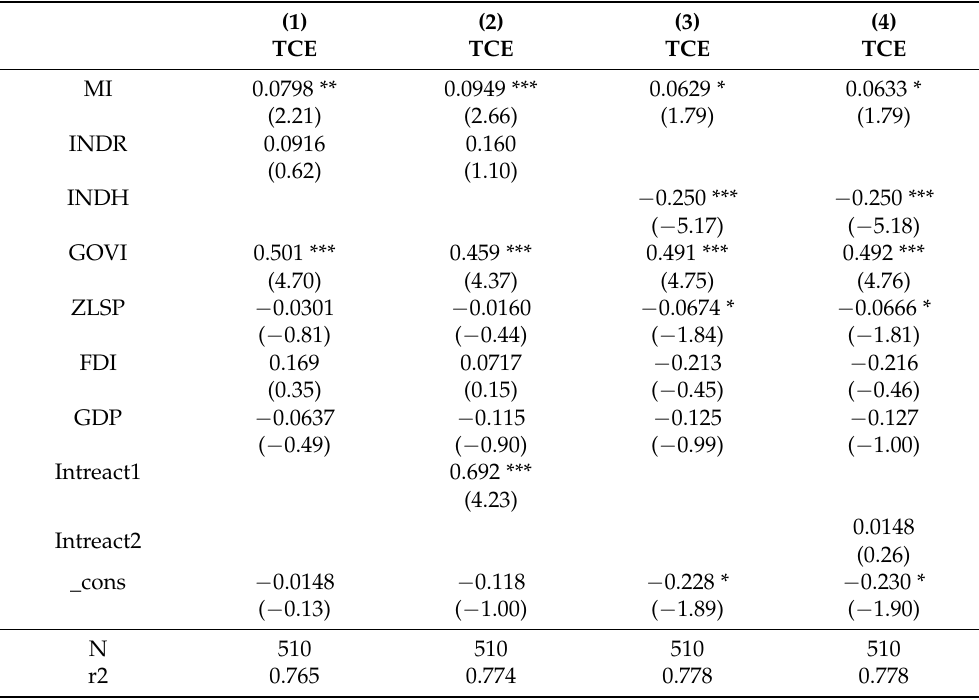
Table 2. Analysis of moderator